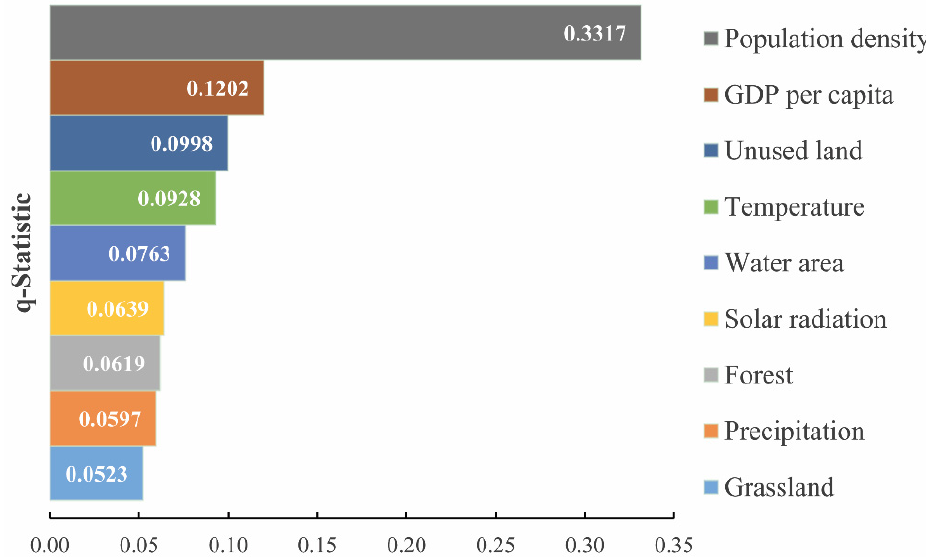
Figure 6. Impact of various drivers on carbon budget changes based on Geodetector analysis. All factors passed the significance test with p values less than 0.01. The land use type refers to the proportion of the total area, and the climate change factor refers to the quantity value per unit area.